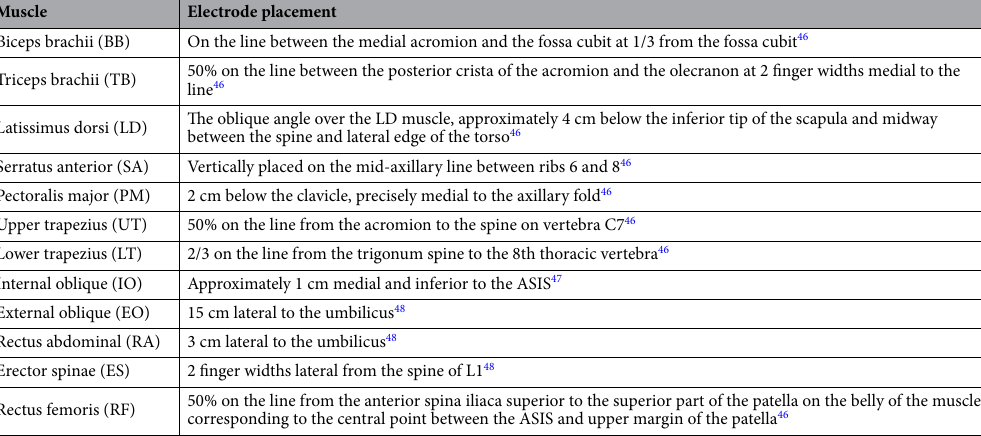
Table 1. Muscle abbreviations and electrode placement.